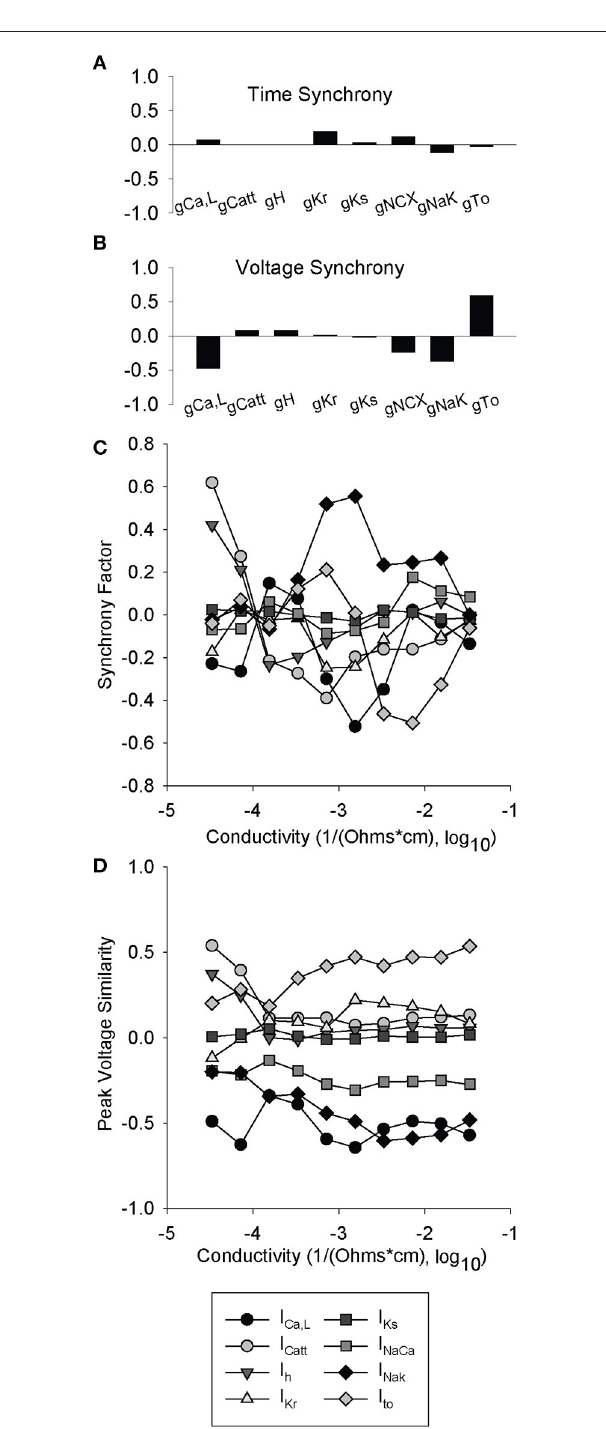
FIGURE 8 | Partial least-squares regression analysis of synchrony factor and peak voltage similarity metrics. 616 simulations were run with two paired cells where one was lognormally perturbed with a mean of 1 and a standard deviation of 0.2, while the other cell was a WT. Ion channel coefficients did not have a significant impact on (A) synchrony factor. In contrast, parameter sensitivity analysis indicates that the impact of I Ca,L , I NaK , and I to greatly